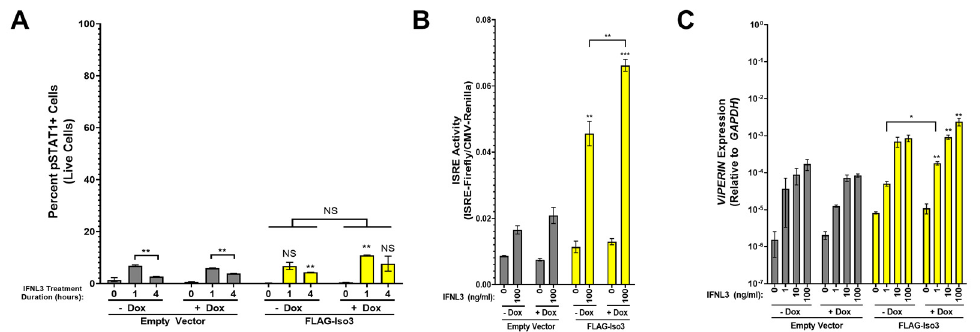
Figure 6. FLAG-Iso3 expression partially augments IFNL signaling. ( A ) pSTAT1 (two independent experiments), ( B ) ISRE activity (three independent experiments), and ( C ) VIPERIN expression (three independent experiments) were analyzed as in Figure 3. Statistical significance represented by lone asterisks reflect comparisons between identically treated EV and FLAG-Iso3 cells. Statistical significance represented by bars and asterisks reflect comparisons between − dox and +dox conditions within each cell line. Error bars represent standard error of the mean. * = p < 0.05, ** = p < 0.01, *** = p < 0.001. NS = not